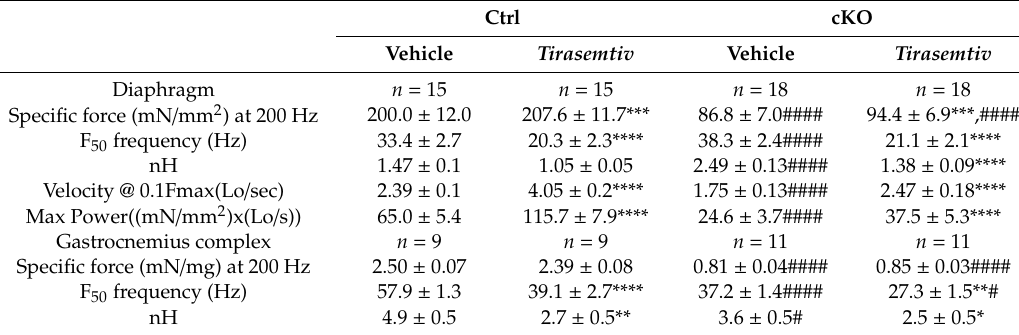
Table 1. E ff ect of tirasemtiv on muscle performance of ctrl and Neb cKO